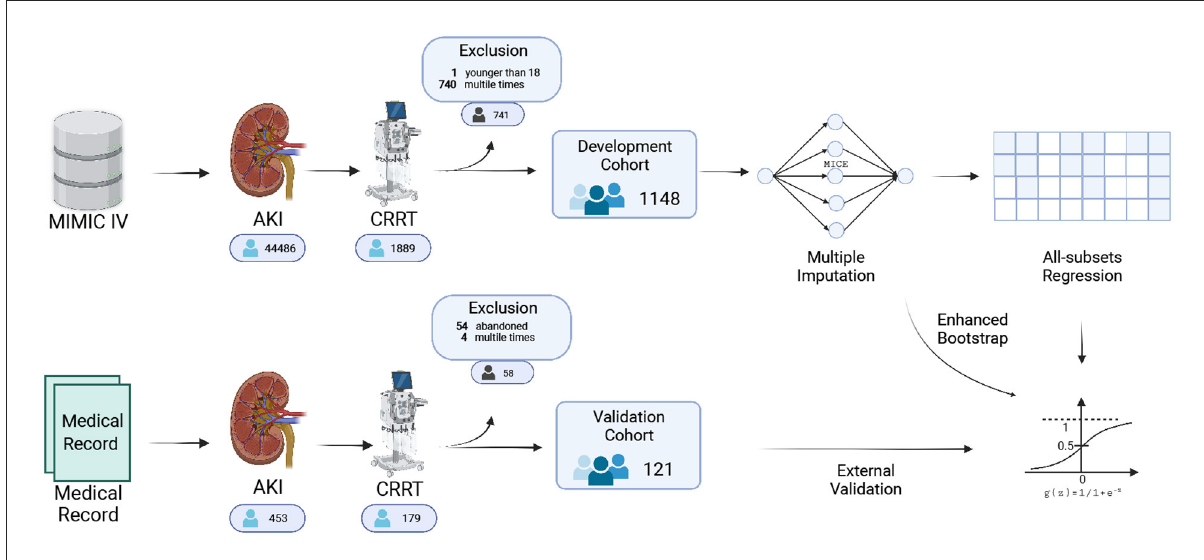
FIGURE1 Flow chart of this